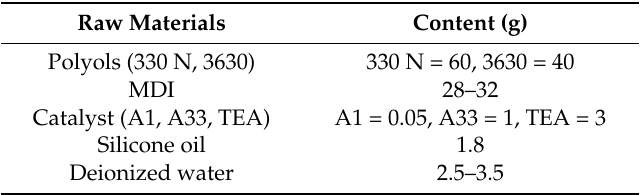
Table 1. Pure polyurethane (PU) foam